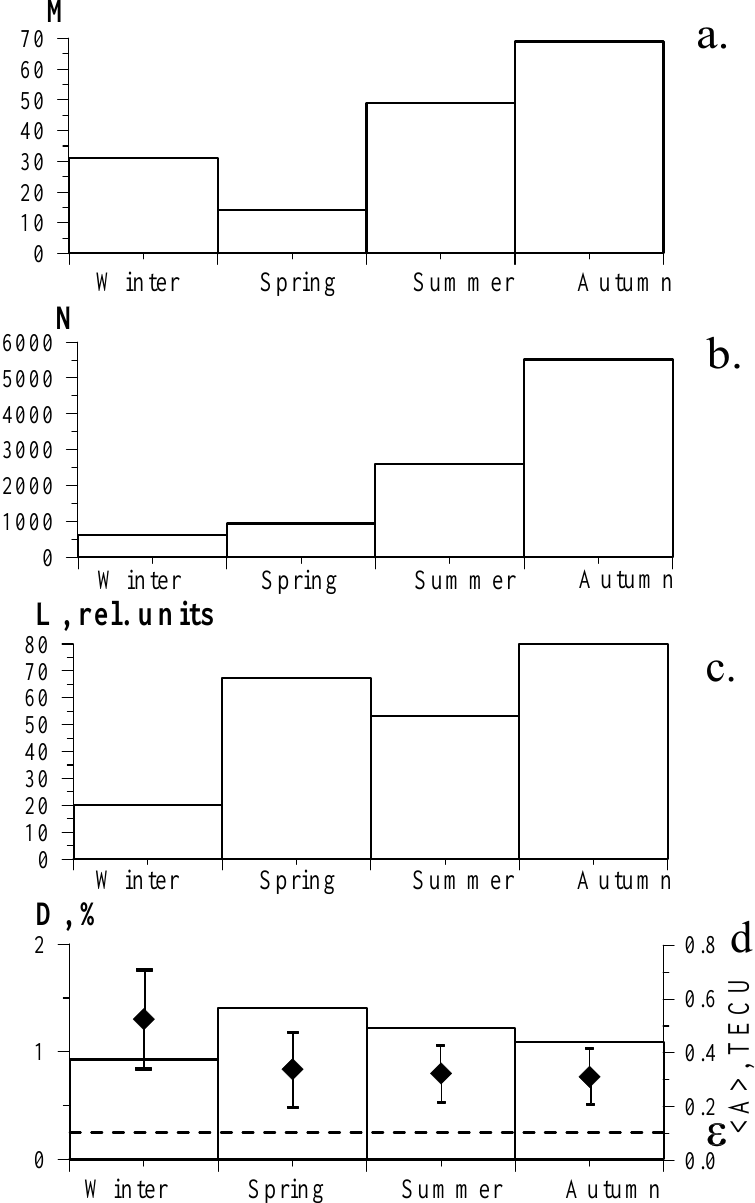
Fig. 2. Seasonal dependence of the density and maximum amplitude of TECS: (a) – number of days M of observation versus time of the year; (b) – number of TECS N ; (c) – mean number of TECS per day L = N/M . (d) – relative TECS density D obtained as the ratio of the number of TECS N to the number of receiver-satellite Lines-of-Sight. Diamonds in panel (d) show the mean values of h A i of the maximum amplitudes | A min | for each season, and vertical lines show their rms. The dashed horizontal line shows the threshold in amplitude ( (cid:15) = 0 . 1 TECU